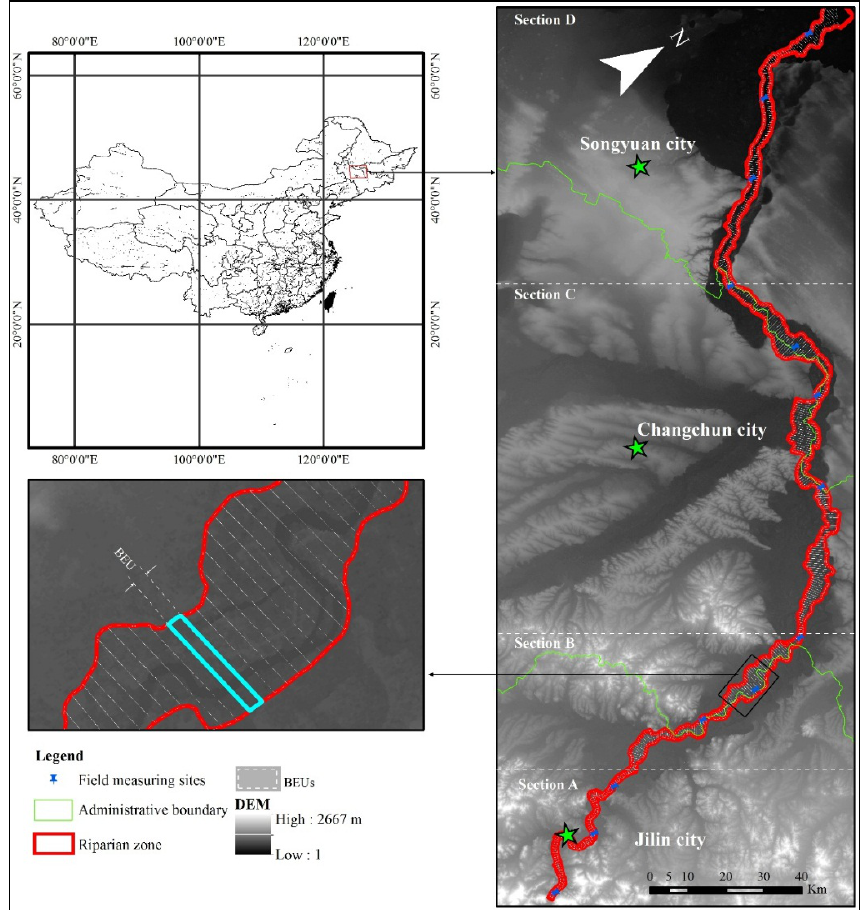
Figure 1. Location of study area and field measurement sites. Sections A, B, C and D represent the four measurement sections. Each section was partitioned into small serial units named basic evaluation units